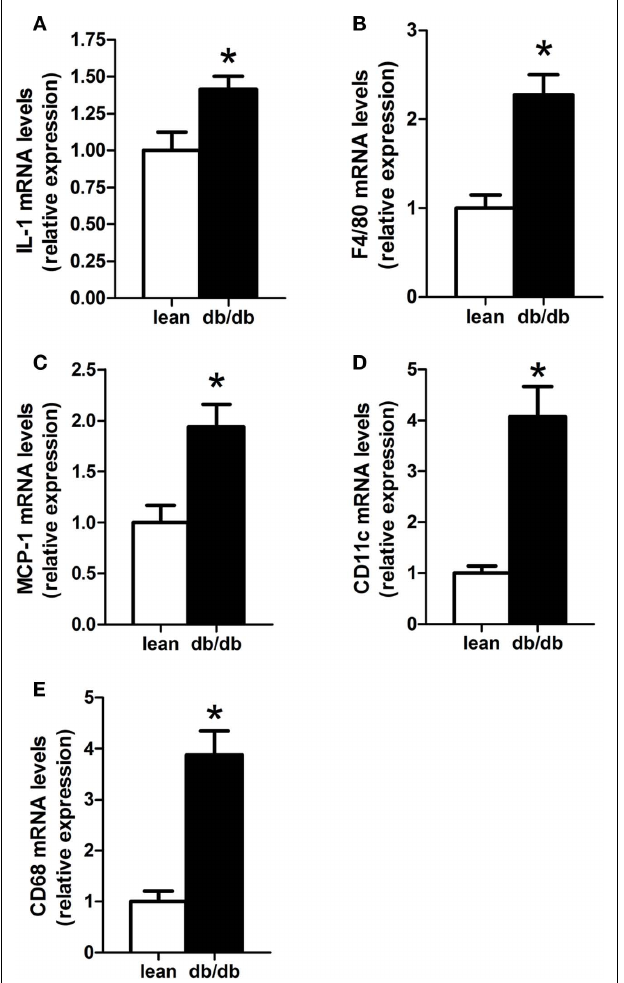
FIGURE 5 | Increased inflammatory markers in the adipose tissue of db / db mice. (A) IL-1, (B) F4/80, (C) MCP-1, (D) CD11c, and (E) CD68 mRNA expression measured in adipose tissue. Mean ± SEM, n = 6/group, * P < 0.05 determined by a two-tailed Student’s t